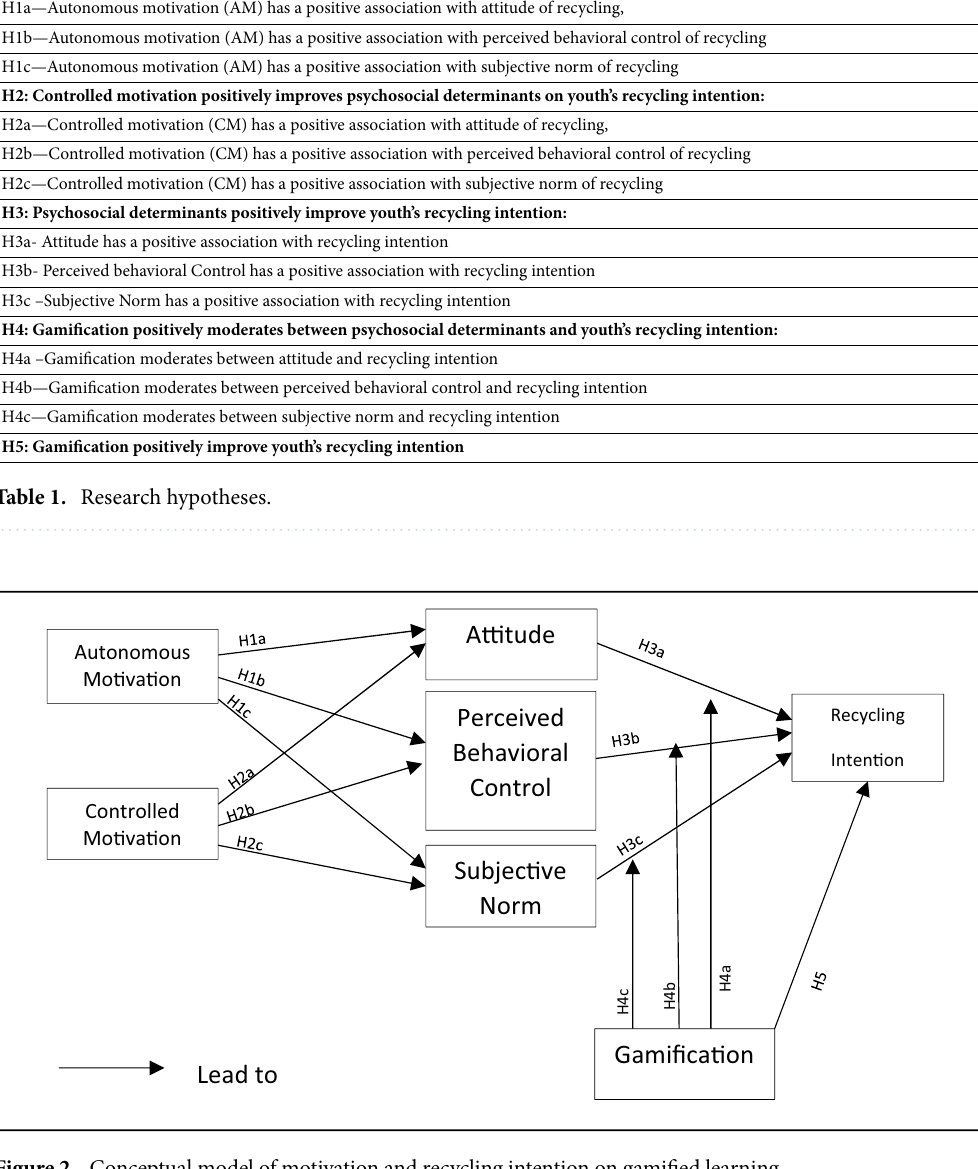
Figure 2. Conceptual model of motivation and recycling intention on gamified